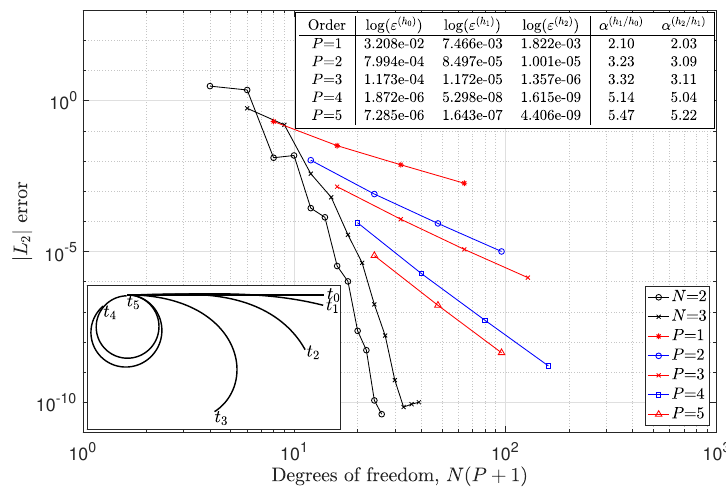
Figure 1. Convergence plot in the L 2 norm of the beam ring case. Table data of convergence rates α for P ∈ [ 1 − 5 ] are embedded. Snap shots of the transient beam motion taken at t i = 100 i s are shown to the lower